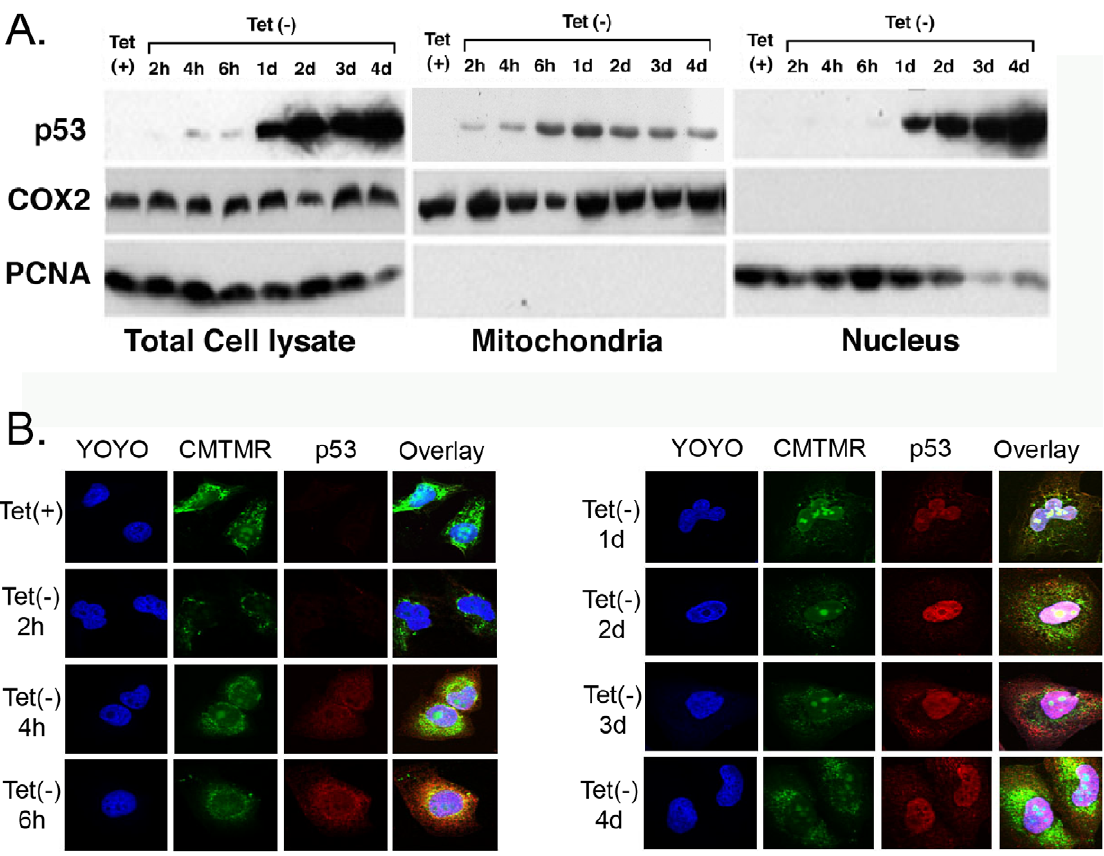
Figure 1. Analysis of p53 in subcellular fractions from senescent EJ-p53 cells. ( A ) Immunoblots using 50 m g protein of total cell lysate and subcellular fractions (mitochondria and nuclear fraction obtained from a sucrose gradient) were subject to SDS-PAGE and subsequently transferred to PVDF filters (Immobilon, Millipore Corp.). Blots were then blocked with BSA and initially probed using a mouse monoclonal antibody specific for p53 (clone 1801, Oncogene Research) followed by HRP-conjugated anti-mouse IgG (Roche) and then developed using ECL kit (GE Healthcare/Amersham). Blots were reprobed using mouse monoclonal specific for the mitochondrial marker, Cox II (Molecular Probes, Invitrogen) and nuclear marker PCNA (Calbiochem) followed by HRP-conjugated anti-mouse IgG and then developed using the ECL kit (GE Healthcare/Amersham). ( B ) Laser confocal image of p53 immunohistochemistry and CMTMR, YOYO fluorescence in EJ-p53 cells. EJ-p53 cells were maintained in ( + ) tet (no p53 expression) and (-)tet 2 hours through 4days (overexpression of wt p53). p53-specific mAb(Oncogene research) and Cy5-labled anti-mouse were used to immunohistochemistry localize p53 in EJ-p53 cells. YOYO was used to stain nuclei and CMTMR was to stain mitochondria. For each image, p53 was re-colored to red, Nuclei was re-colored to blue, and mitochondria was re-colored to green. p53 localization in p53-induced senescence in EJ-p53 cells was determined by overlay.